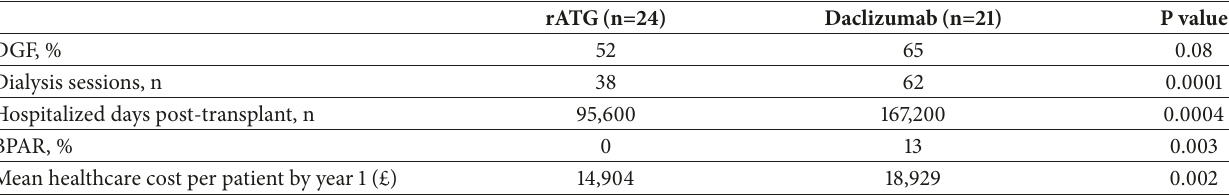
Table4:Resultsofaretrospectiveanalysisofprospectivelycollectedfrom45frequency-matchedDCDkidneytransplantpatientsgivenrATG (2.5 mg/kg intraoperatively and 1.25 mg/kg on day 4) or daclizumab (2 x 1 mg/kg) as induction, with immediate CsA, MMF and steroids